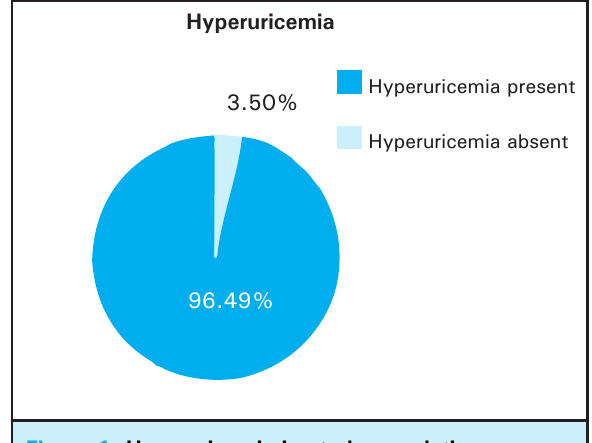
Figure 1. Hyperuricemia in